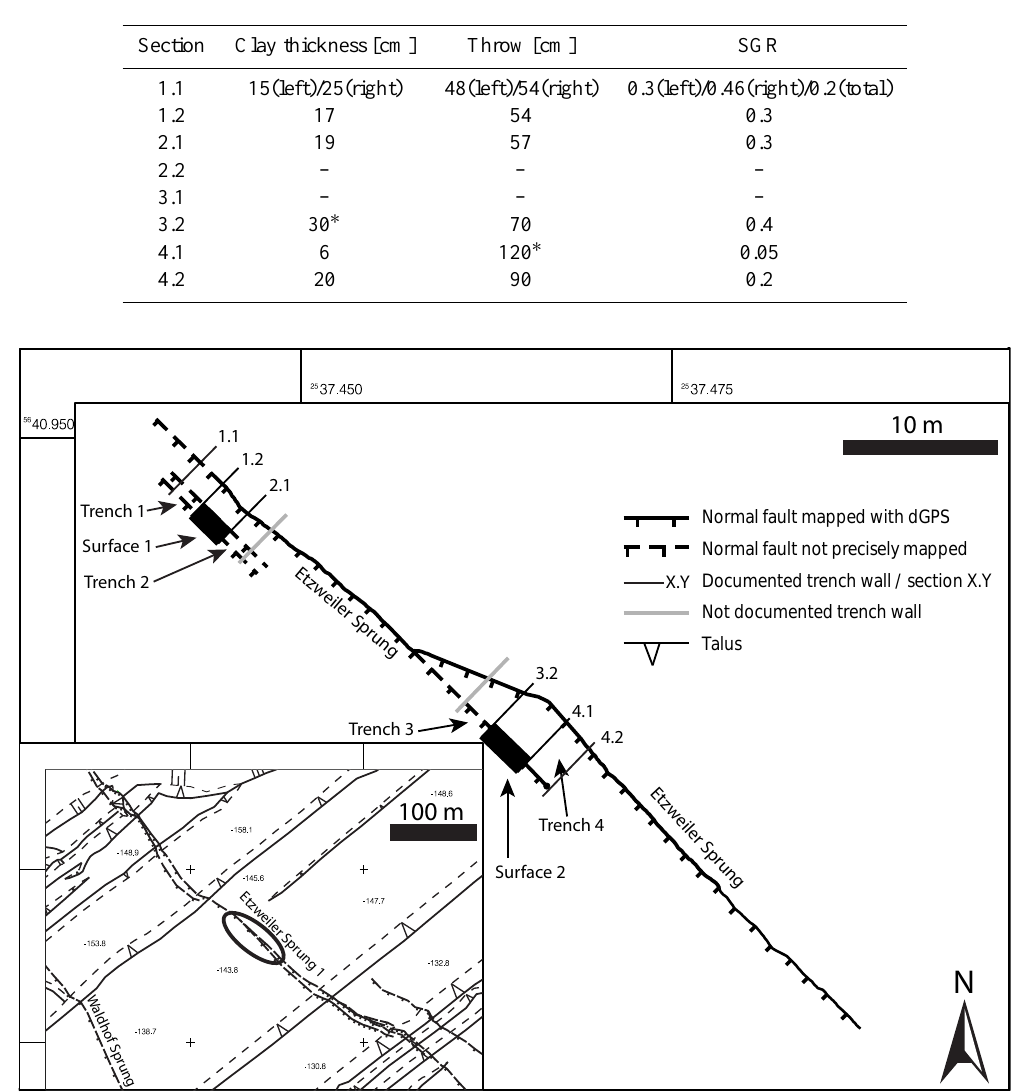
Table 1. Summary of SGR values in the presented cross sections. In section 1.1 two fault strands are visible (cf. Fig. 8a), source clay thickness and throw values are given separately and SGR values provided for each fault strand and for the total throw. Estimated values marked with ∗ .